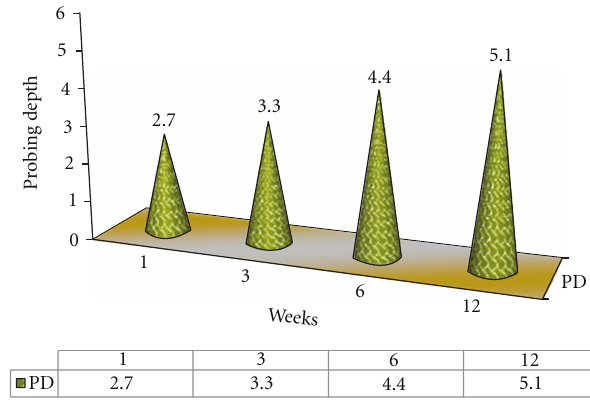
Figure 1: Mean probing depth (PD) values of Control Group A during various intervals of weeks.